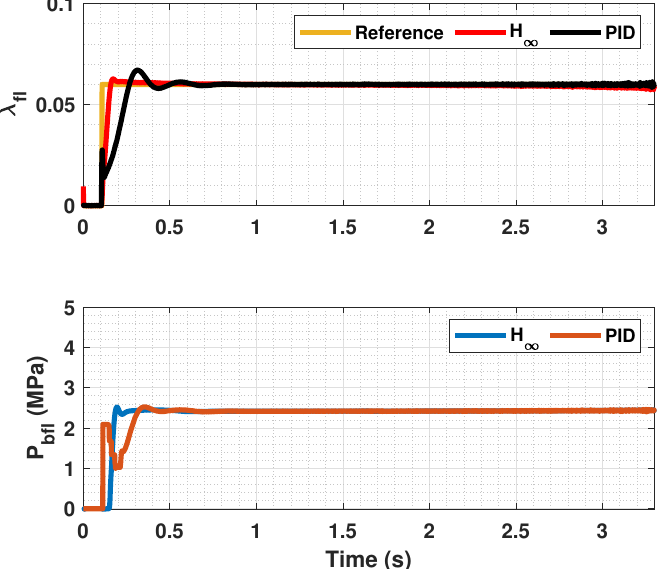
Figure 8. Front wheels tire slip, reference tire slip and brake pressure for µ max =